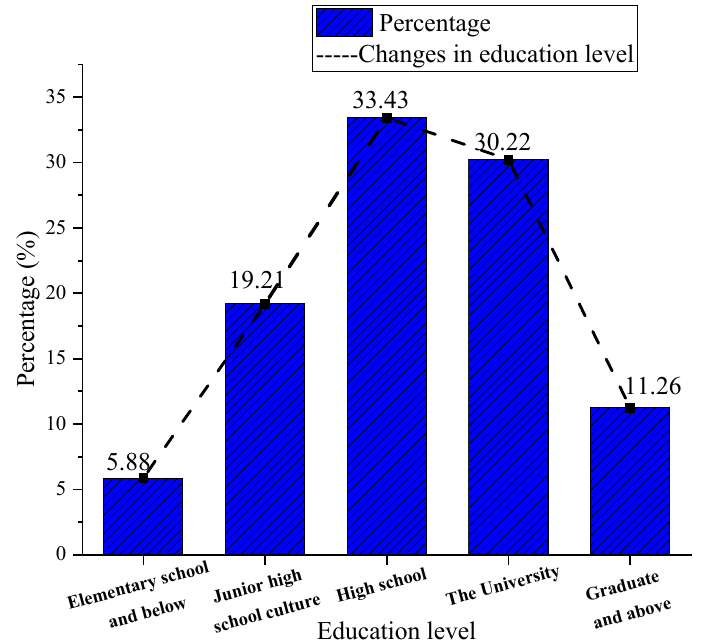
Figure 2. Distribution of the educational level of the surveyed residents.